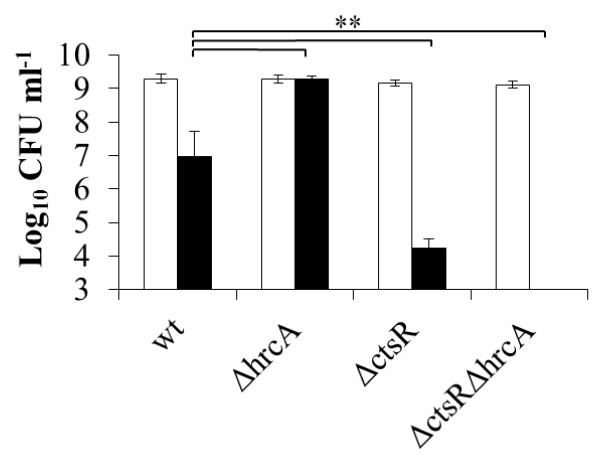
Involvement of CtsR and HrcA in the ability to form colonies at elevated temperature.L. plantarum WCFS1 (wt), NZ3410 (ΔctsR), NZ3425CM (ΔhrcA), and NZ3423CM (ΔctsRΔhrcA) cultures were serial diluted on MRS plates and incubated at control (30°C; white bars) or elevated temperature (42°C; black bars). Asterisks indicate p-value < 0.001. Data shown are mean ± standard deviation of 3 independent experiments.